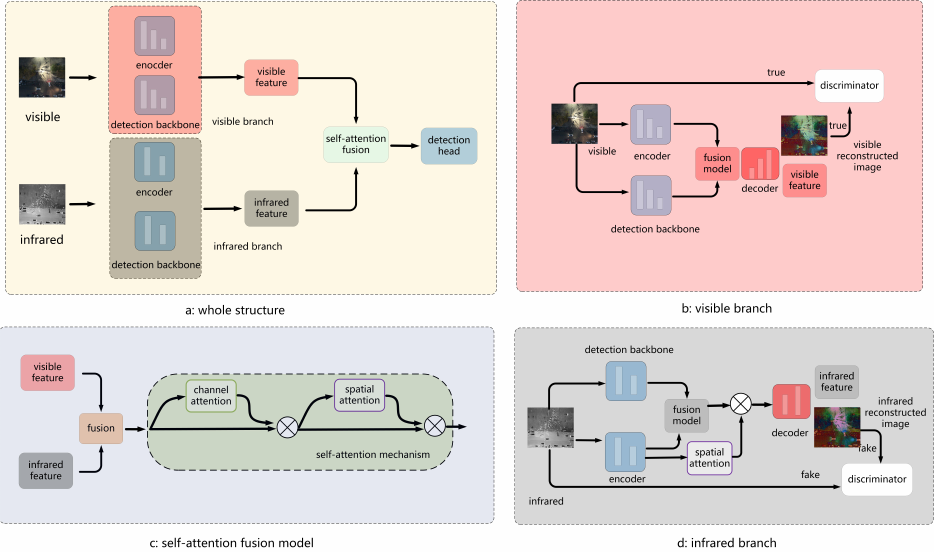
Figure 3. The overall structure of GF-Detection is illustrated in figure. The whole structure of GF- detection contains the visible branch, infrared branch and self-attention fusion model. Visible branch is aiming to reconstruct the visible images via the fusion of the visible images and detection features. The infrared branch aims to reconstruct the infrared images via the fusion of the infrared images and detection features. The trained detection models extract the detection features from the visible and infrared images into the image reconstruction. The self-attention fusion model fuses two fused features and sends them to the detection